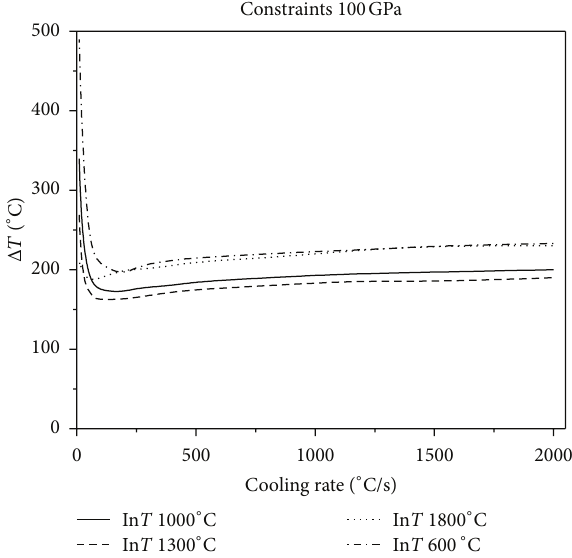
Figure 5: Relationship between critical fracture temperature Δ𝑇 corresponding to different thermal shock initial temperature and cooling rate which Young’s modulus of constraint material is 650